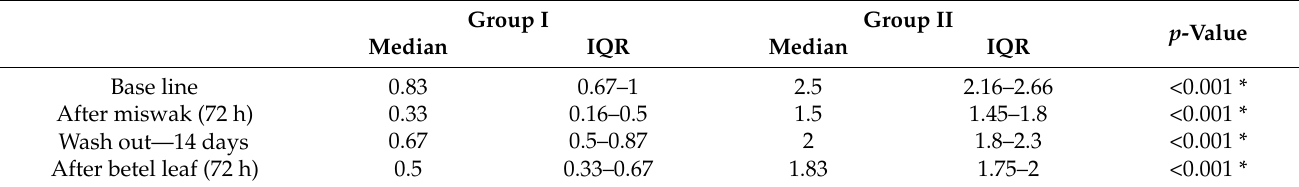
Table 1. Comparison of Plaque Index between the groups at each visit.